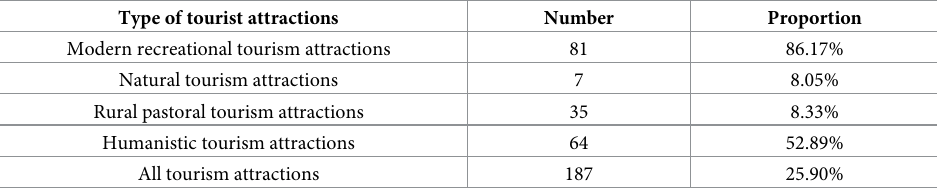
Table 4. Proportion composition of different types of tourist attractions in the demonstration